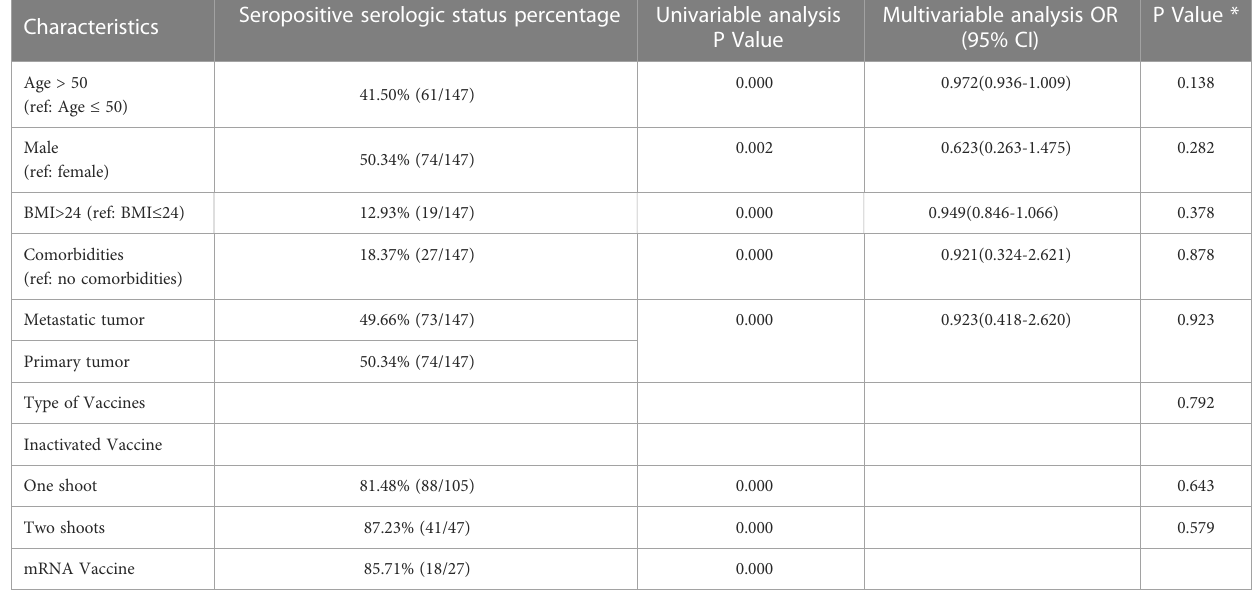
TABLE 3 Univariable and multivariable analysis of factors potentially associated with serologic response.